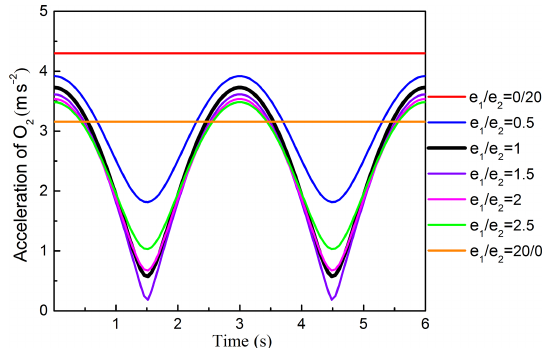
Figure 14. Effects of e 1 /e 2 on the acceleration when ω 1 (cid:54)= ω 2 and